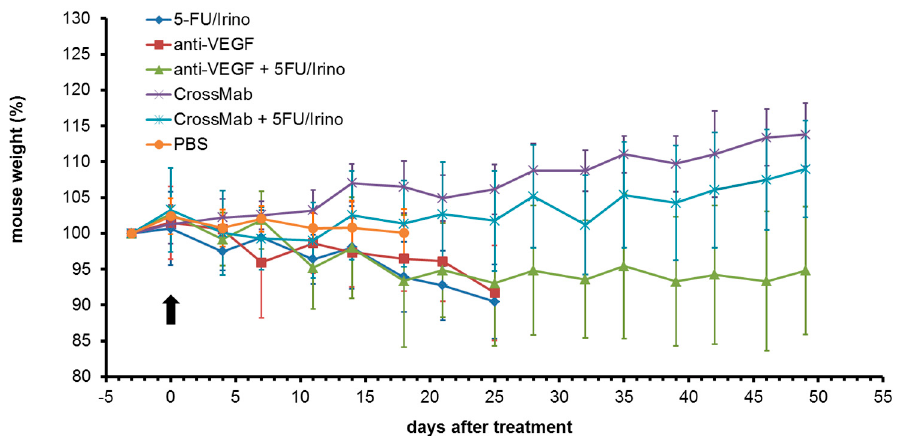
Figure 4. Analysis of mouse weight during treatment normalized to pre-treatment weight. Mice were treated once weekly starting on day 0 (arrow). Values are means ± standard deviation ( n = 10).